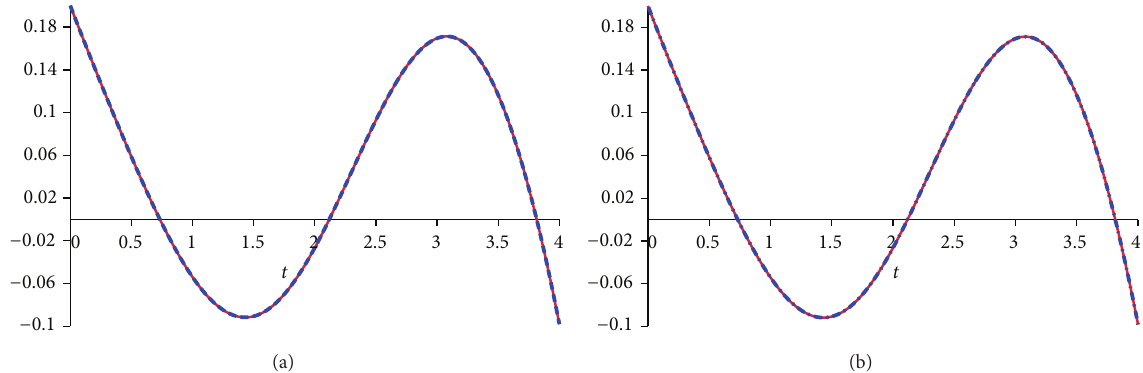
Figure 1: Plots of RPS solution versus RKM and PCM solutions for (26) and (27) versus time: (a) (—): 40 th terms RPS approximation; (--): RKM solution; (b) (—): 40 th term RPS approximation; (- ⋅ -): PCM